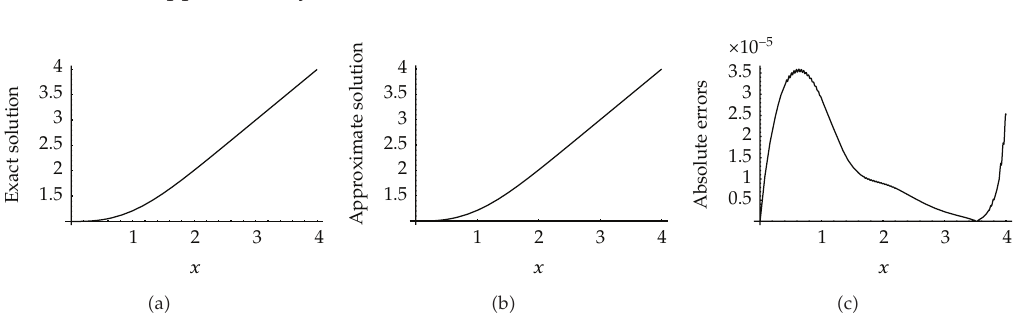
Figure 3: The numerical results for Example 4.3. (cid:3)(cid:3) a (cid:4) : exact solution; (cid:3) b (cid:4) : approximate solution; (cid:3) c (cid:4) : absol- ute error. (cid:4)